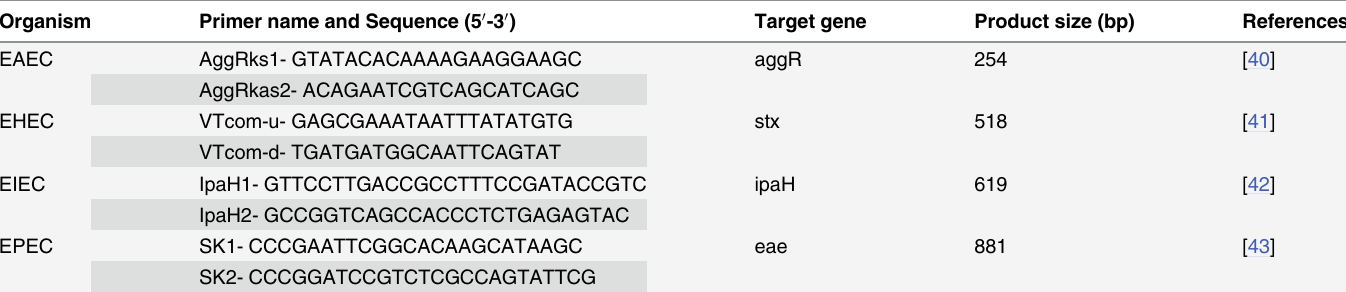
Table 1. Primer sequence and predicted sizes of amplicons in conventional and real-time multiplex PCRs.